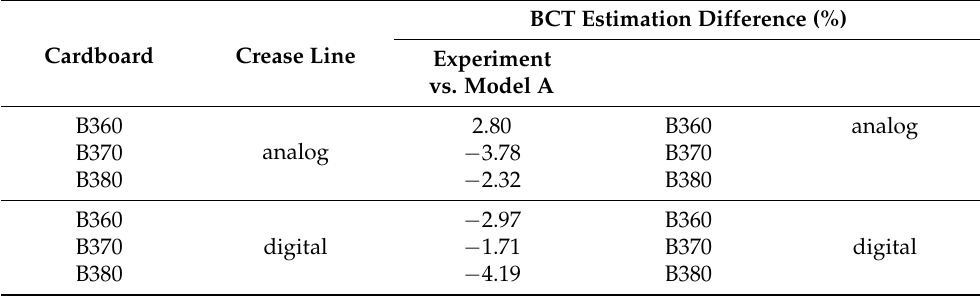
Table 9. Percentage difference between experimental results and estimations using two different numerical models as well as a difference between the BCT computed using Model A and Model B.